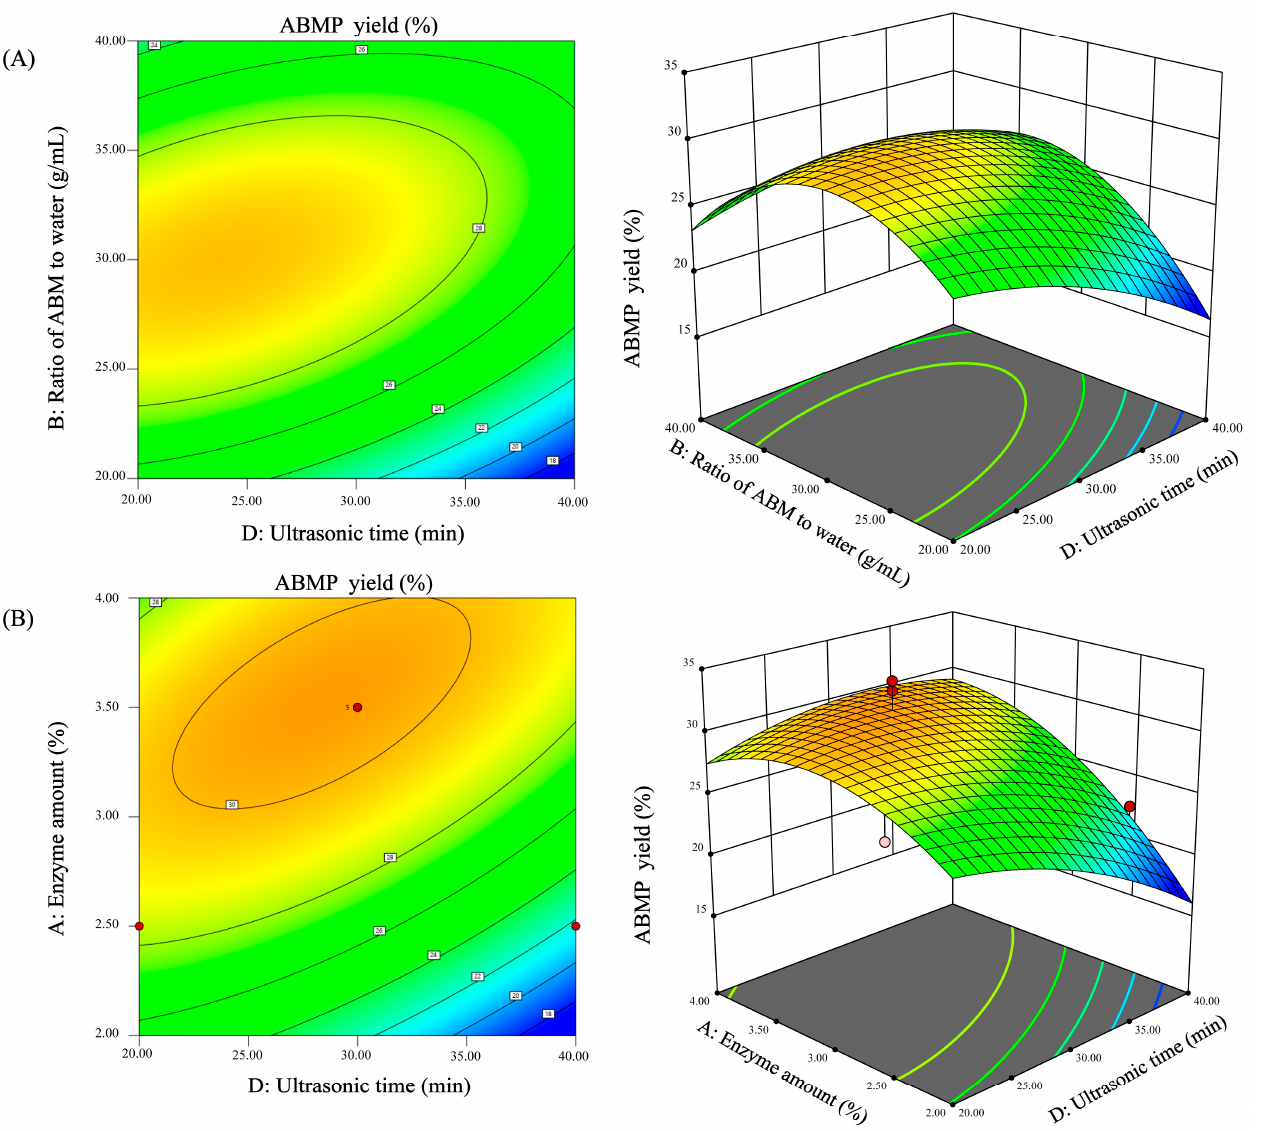
Figure 2. Response surface and contour map of interactive effect between different factors. ( A ) Interaction between ultrasonic time and ratio of ABM to water. ( B ) Interaction between ultrasonic time and enzyme amount.